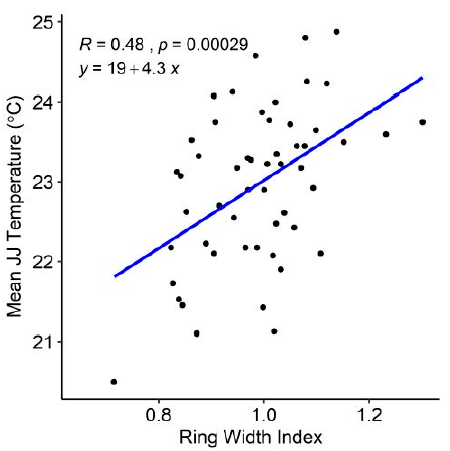
Figure 6. Linear regression between mean June ‐ July temperature and ring width indices. Table 2. The calibration ‐ verification statistics of mean June ‐ July temperature reconstruction.